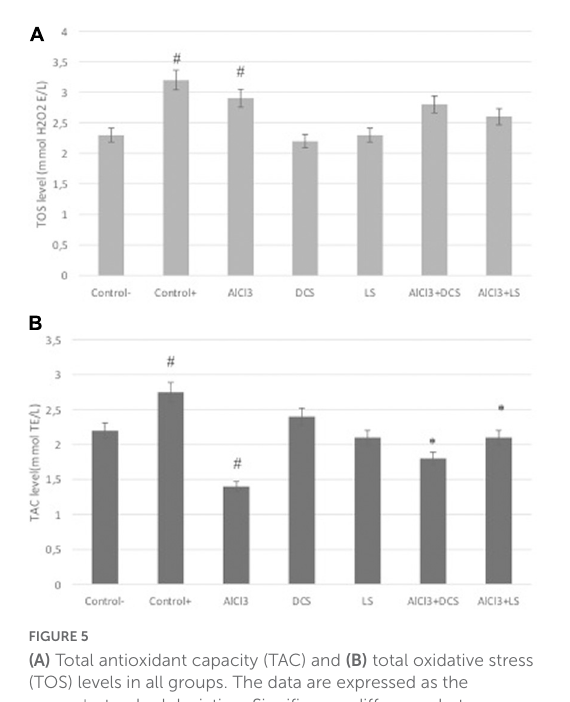
FIGURE5 (A) Total antioxidant capacity (TAC) and (B) total oxidative stress (TOS) levels in all groups. The data are expressed as the mean ± standard deviation. Significance difference between groups indicated by: # between control and AlCl 3 , * between AlCl 3 and treatment